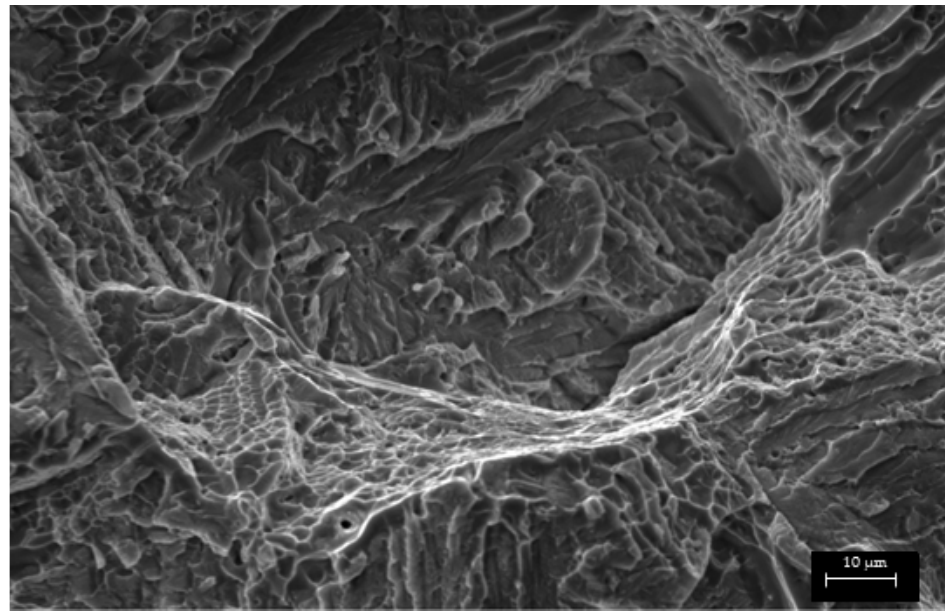
Figure 9. SEM fractographs showing the presence of ductile dimples in HT-A impact toughness specimen.